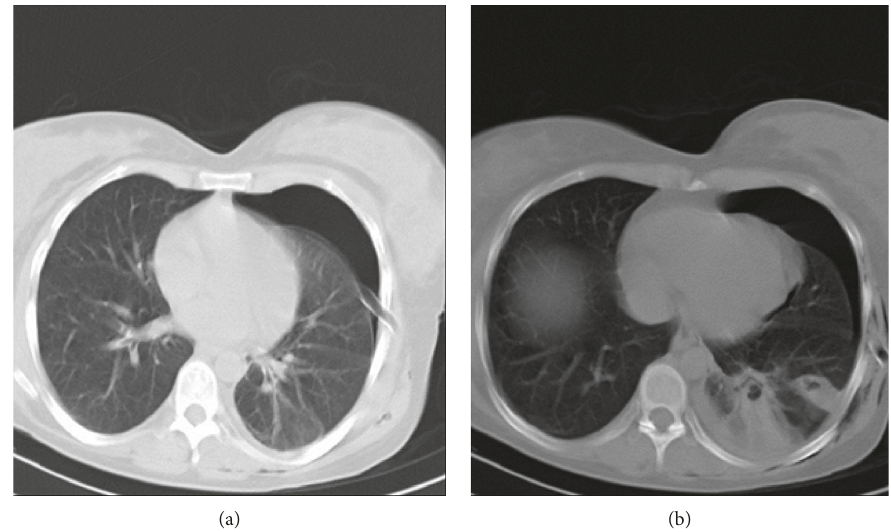
Figure 2: Collapsed consolidation of the left lower lobe with pneumothorax and the presence of relatively two separated small-sized cystic lesions within the collapsed